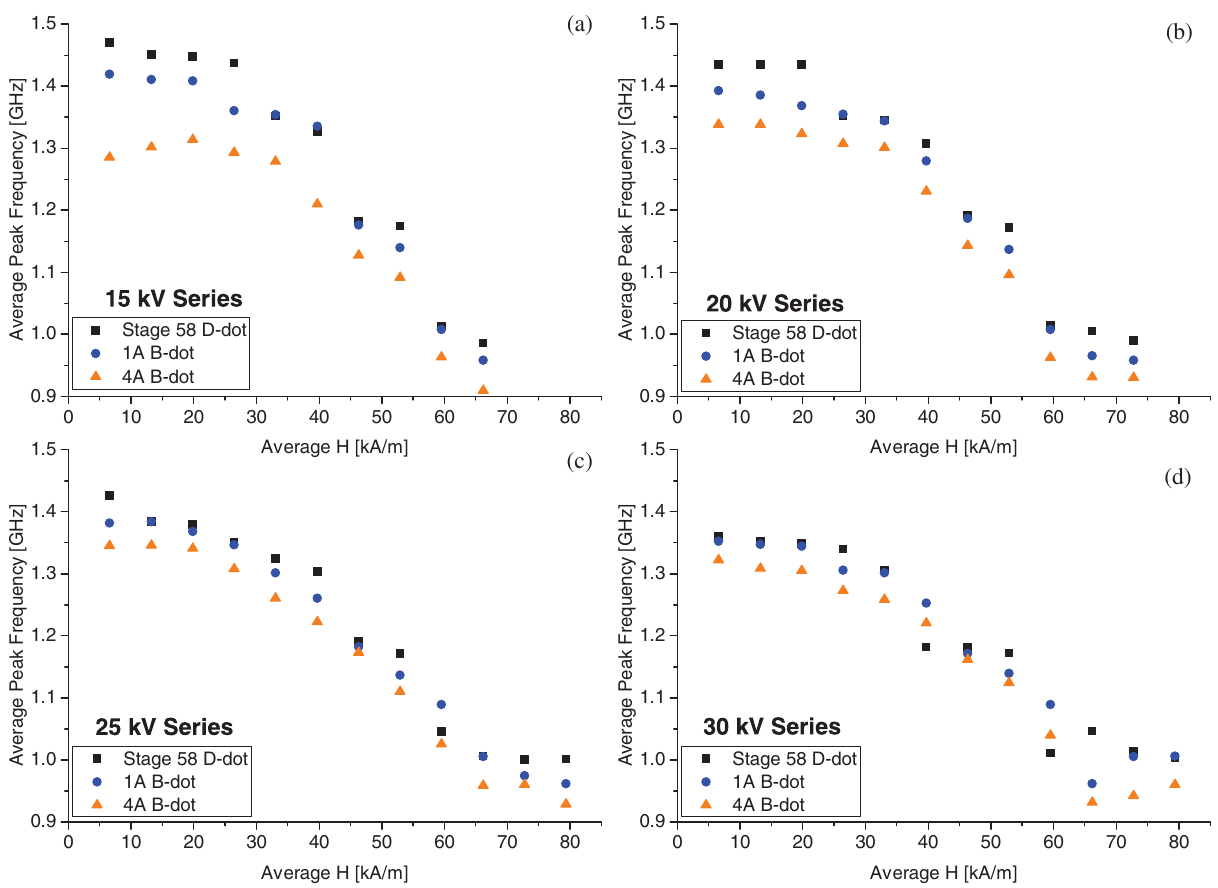
FIG. 10. Peak frequency of the Stage 58 D-dot, 1A B-dot, and 4A B-dot signals as a function of applied H field for the 15 kV (a), 20 kV (b), 25 kV (c), and 30 kV (d) Marx charge experimental series. In plot (a), the magnetic field biasing the NLTL is decreased as shot number is increased. Because multiple shots were taken at each solenoid current setting and would, thus, have the same applied H field value, the average peak frequency for each set of shots at a given applied H are